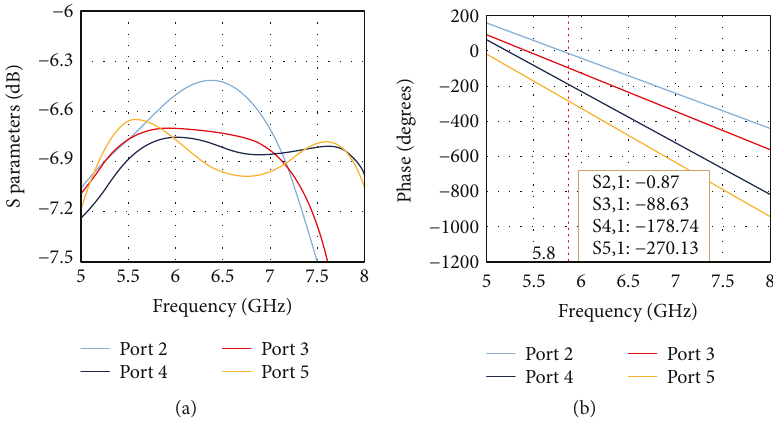
Figure 4: Amplitude (a) and phase (b) distribution of proposed feeding